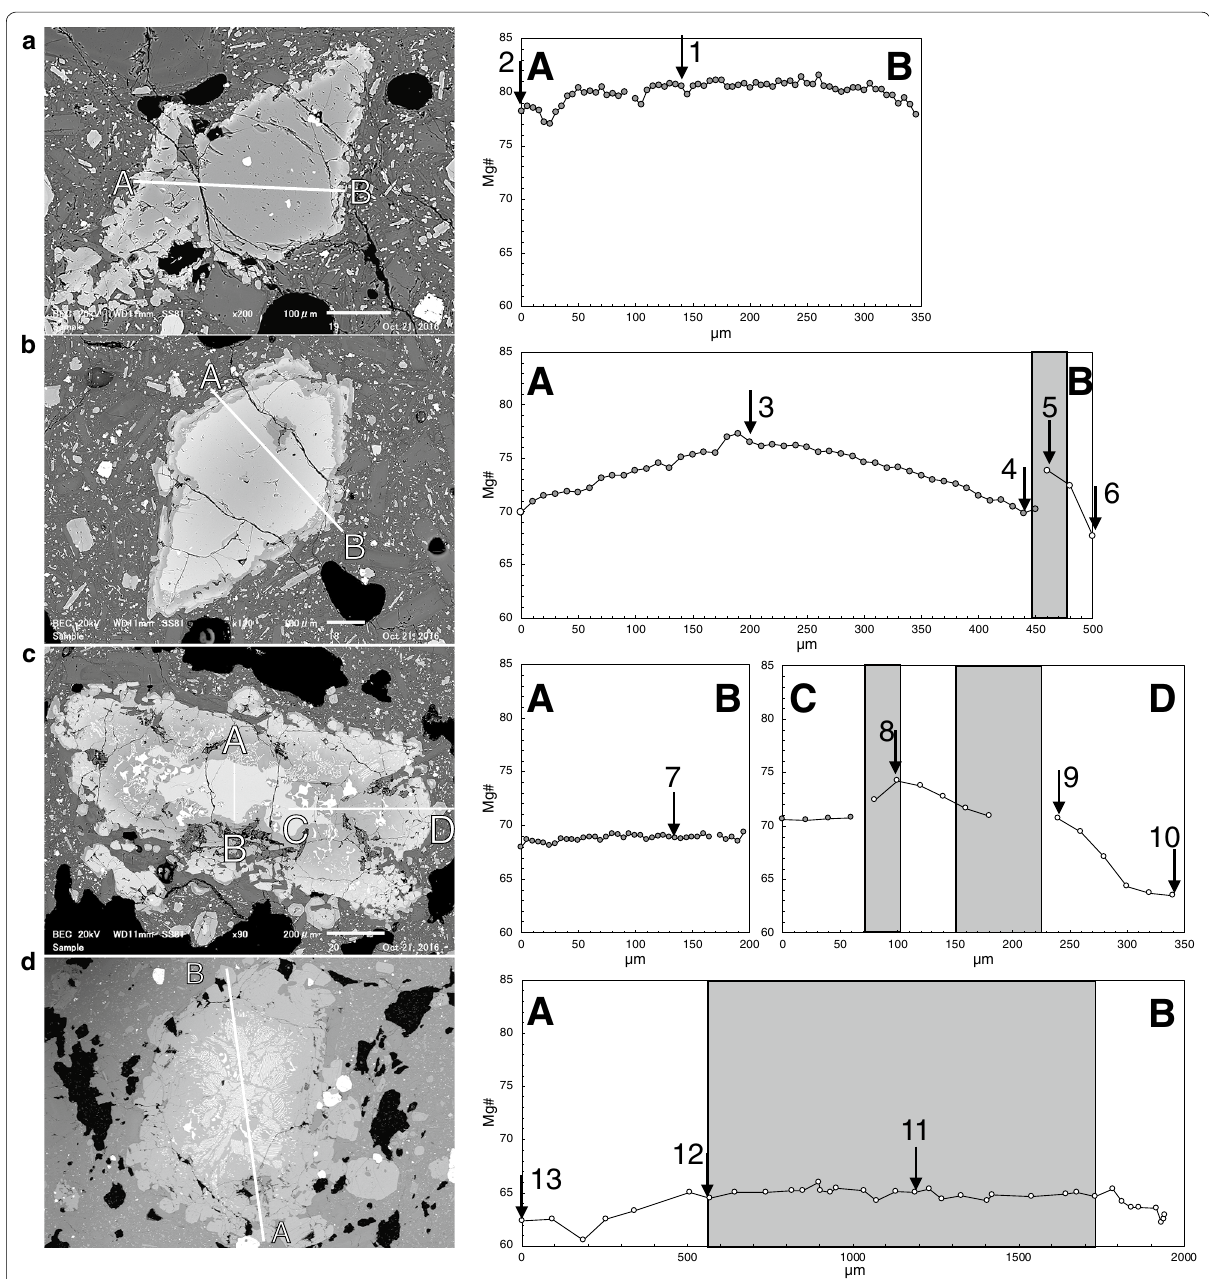
Fig. 4 Zoning profiles of olivine and opx in the examples shown in Fig. 2. Gray and white circles are olivine and opx analyses, respectively. The shaded areas represent symplectite or lamellar zones. Numbered arrows indicate locations of analyses given in Additional file